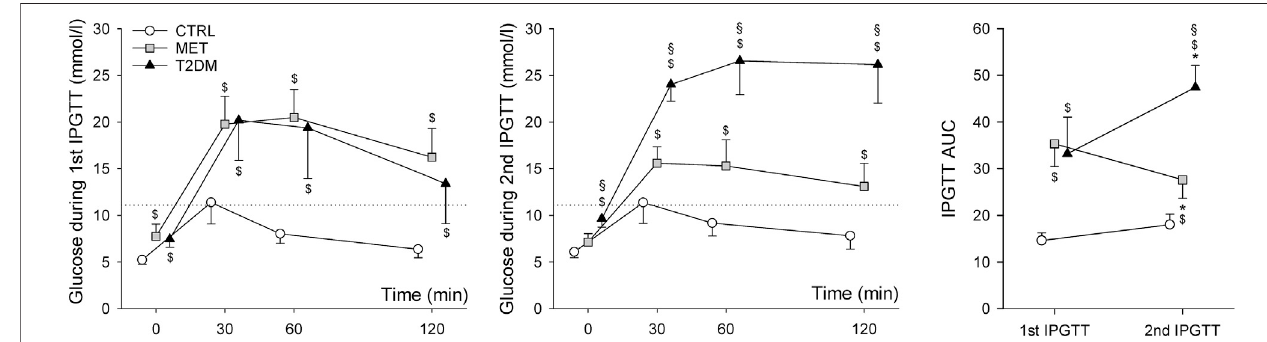
FIGURE 2 | Blood glucose levels and the corresponding AUC values belonging to the 1 st and 2 nd IPGTT measurements during the pretreatment period. * p < 0.05 vs . 1 st IPGTT; $ p < 0.05 vs . CTRL; § p < 0.05 vs . MET. Abbreviations: CTRL, control group; MET, metformin-treated model of type 2 diabetes; T2DM, untreated model of type 2 diabetes; IPGTT, intraperitoneal glucose tolerance test. Dotted line denotes the threshold glucose levels for 120-min blood glucose measurements (11.1 mmol/L).